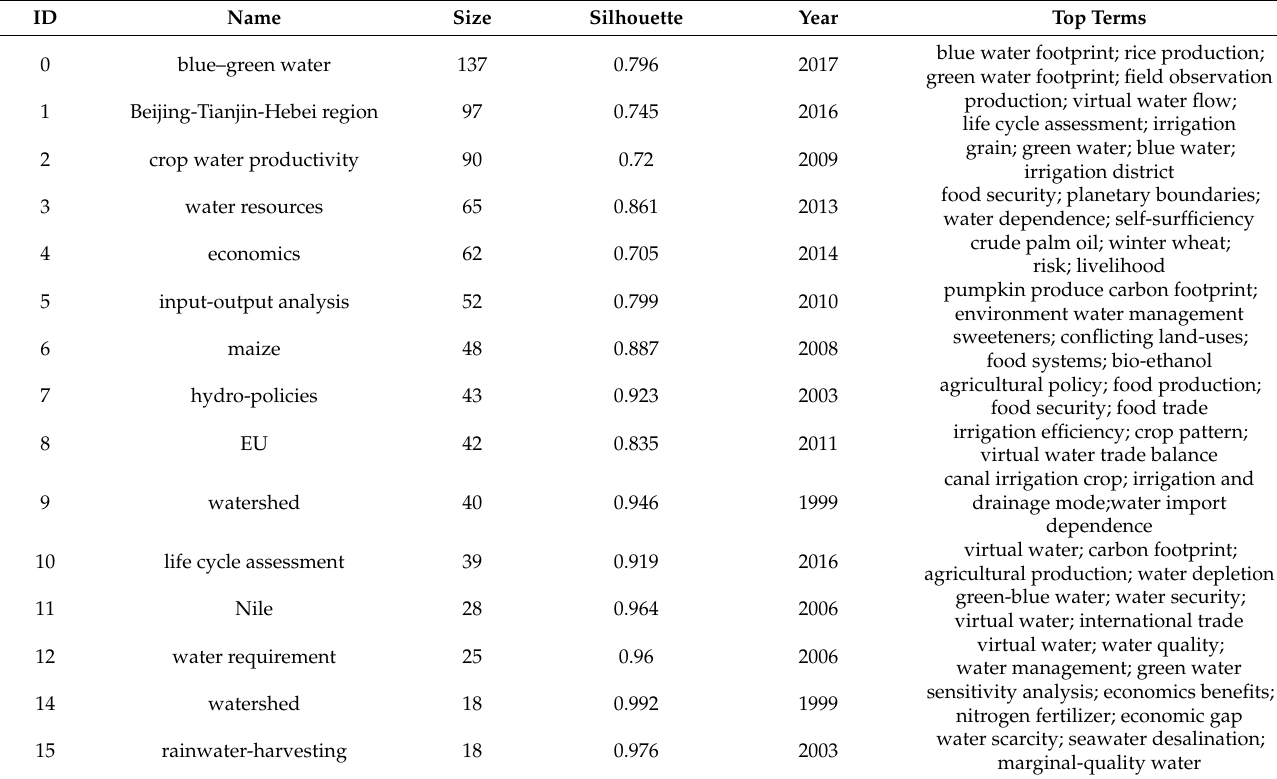
Table A2. The information of main clusters on co-citation